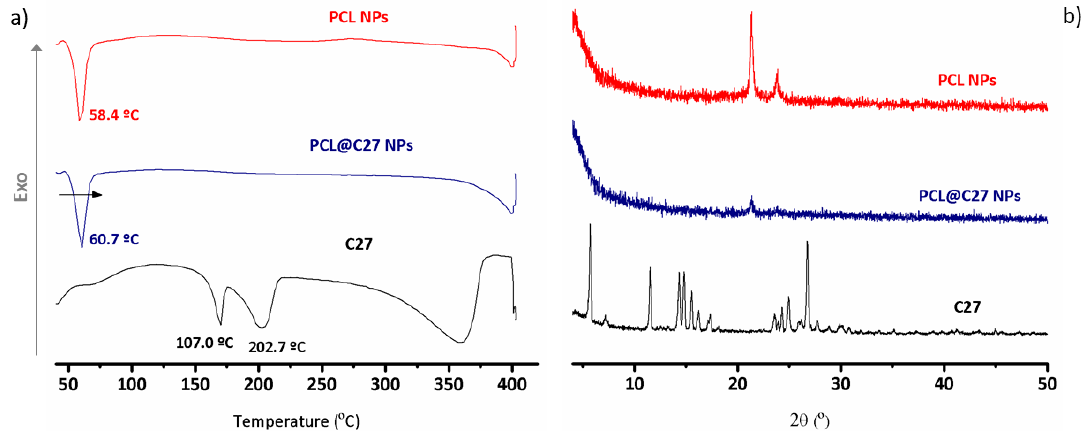
Figure 3. Physicochemical characterization of chromone C27, PCL NPs, and PCL@C27 NPs using ( a ) differential scanning calorimetry (DSC) between 40 and 400 °C, and ( b ) powder X-ray diffraction (PXRD) in the range of 4–50 °C.